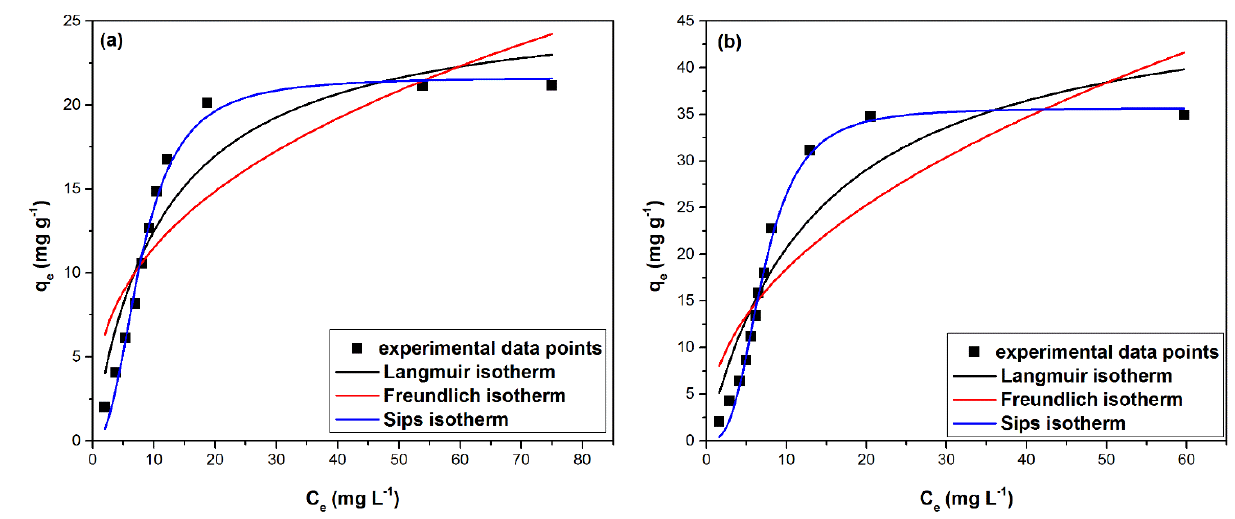
Figure 12. Langmuir, Freundlich and Sips isotherms: ( a ) MgSiO 3 -DB18C6, ( b ) MgSiO 3 -DB30C10.